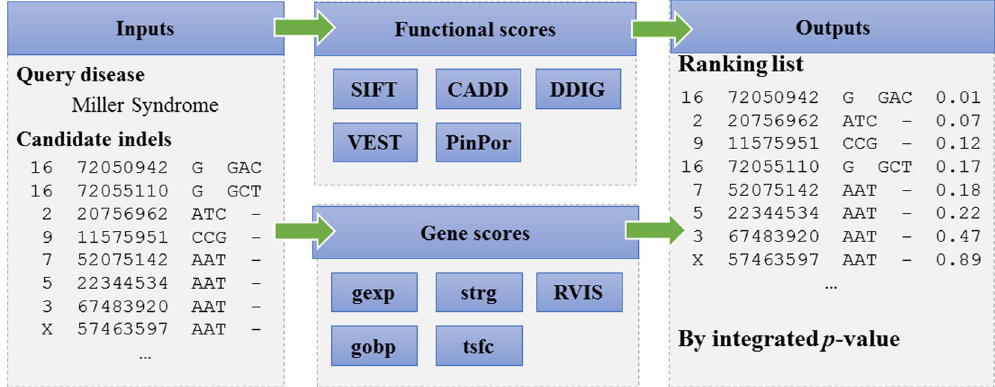
Figure 1. Schematic overview of our method. Our method takes a list of candidate indels and a disease of interest as input and outputs a prioritized list according to the likelihood of causing the disease. For each indel, we extract five kinds of functional scores, four kinds of association scores and RVIS score as genomic features. Each genomic feature is transformed into a p -value and we use Fisher’s method with independence correction to integrate these p -values into an integrated p -value, which is used to prioritize candidate